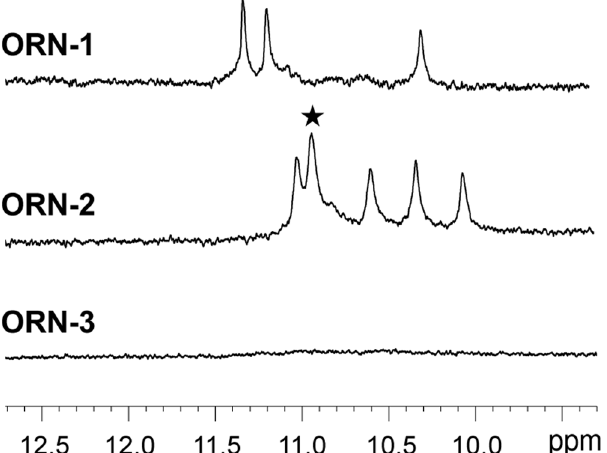
Figure 2. Imino proton NMR spectra of ORN-1, ORN-2 and ORN-3 in the presence of 100 mM KCl and 10 mM potassium phosphate buffer (pH 6.8), 25 °C. Asterisk indicates an overlapping of two